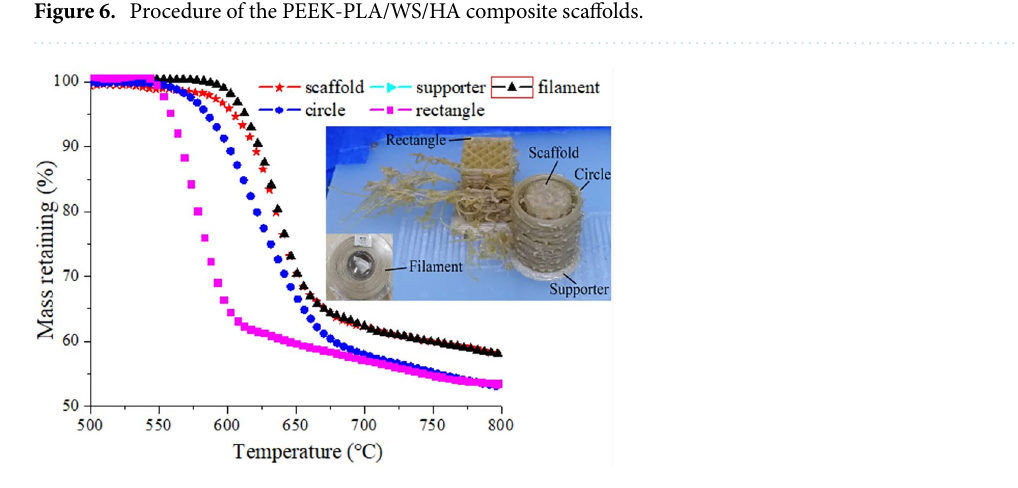
Figure 7. Thermal stability of PEEK in various